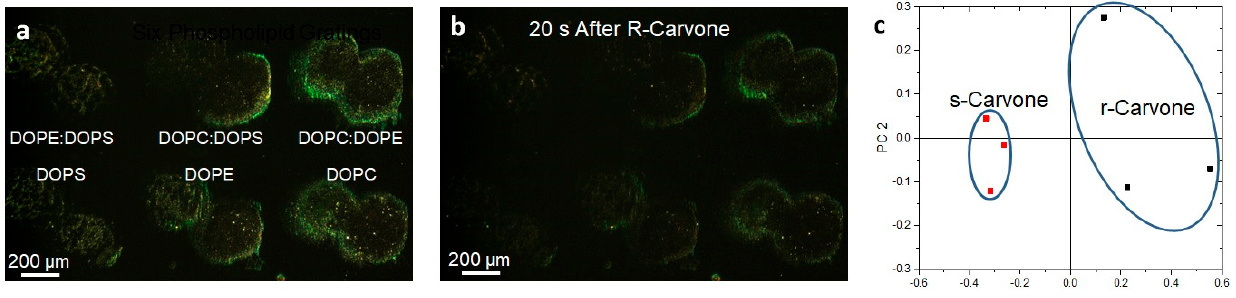
Figure 7. Lipid multilayer gratings respond to carvone vapors with enantiomer dependence. ( a ) Lipid multilayer gratings of DOPC, DOPE, DOPS, 1:1 DOPC:DOPE, 1:1 DOPC:DOPS, and 1:1 DOPE:DOPS were fabricated on a polystyrene surface. The sample was illuminated by white light from an angle and an image was taken of the light diffracted from the gratings as illustrated in Figure 5. ( b ) The gratings were then exposed to carvone vapors at saturation. ( c ) Utilizing three different experiments for each enantiomer, clustering was observed using multivariable analysis using 20 to 40 s time point data to construct the response of the gratings in PCA space.